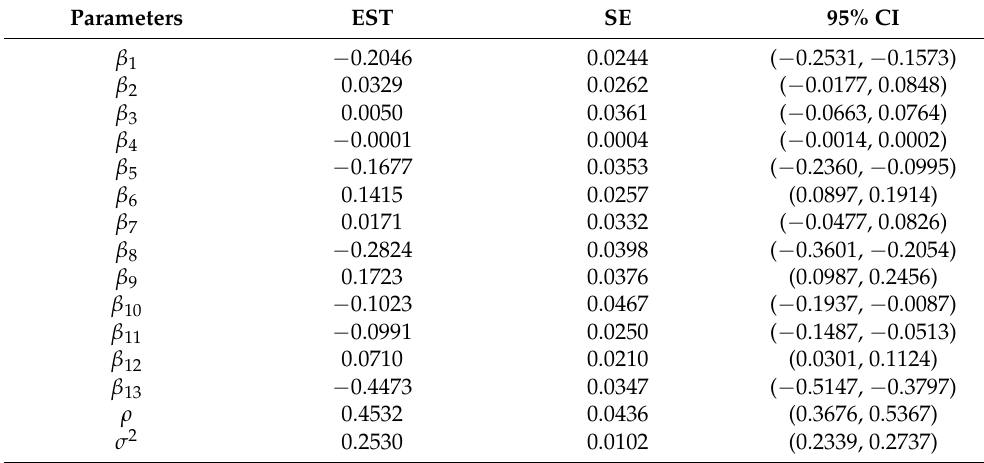
Table 7. Bayesian estimation results based on SAR models [2] in the Boston housing price data